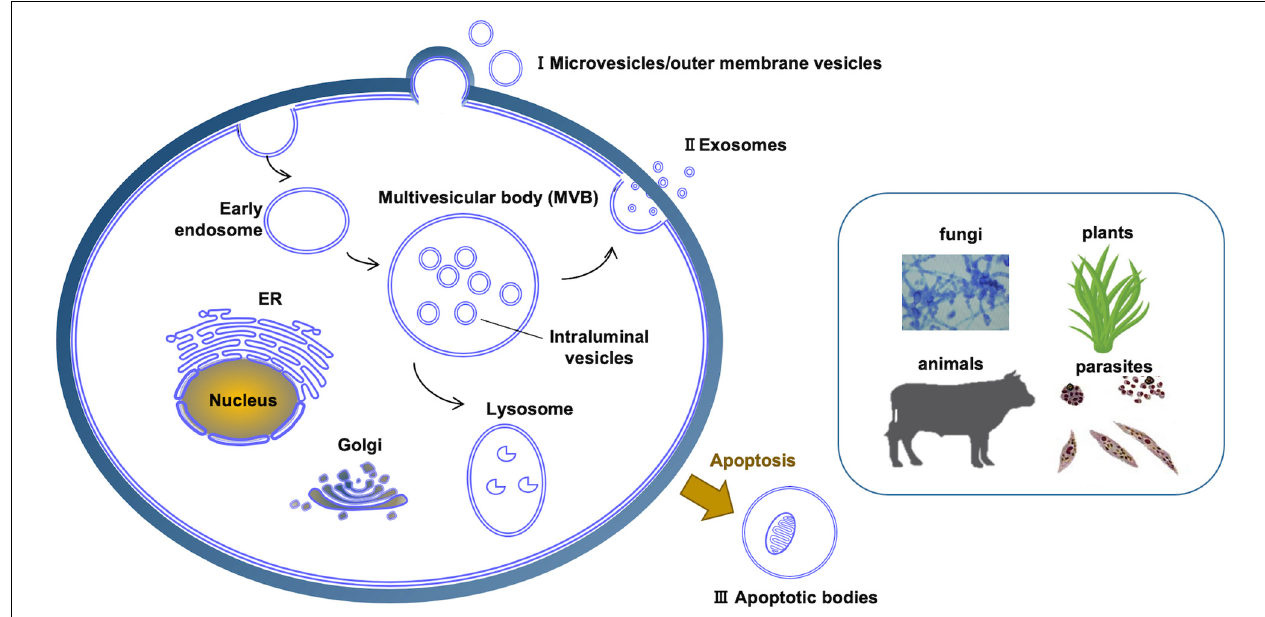
FIGURE 2 | Different kinds of extracellular vesicles produced across diverse eukaryotic kingdoms. (I) Microvesicles are produced directly by pinching off of the plasma membrane. (II) Exosomes are produced through the intermediate structure of multivesicular bodies. (III) Apoptosis results in apoptotic bodies that constitute another type of extracellular vesicle. In plants and fungi, extracellular vesicles must cross a cell wall.